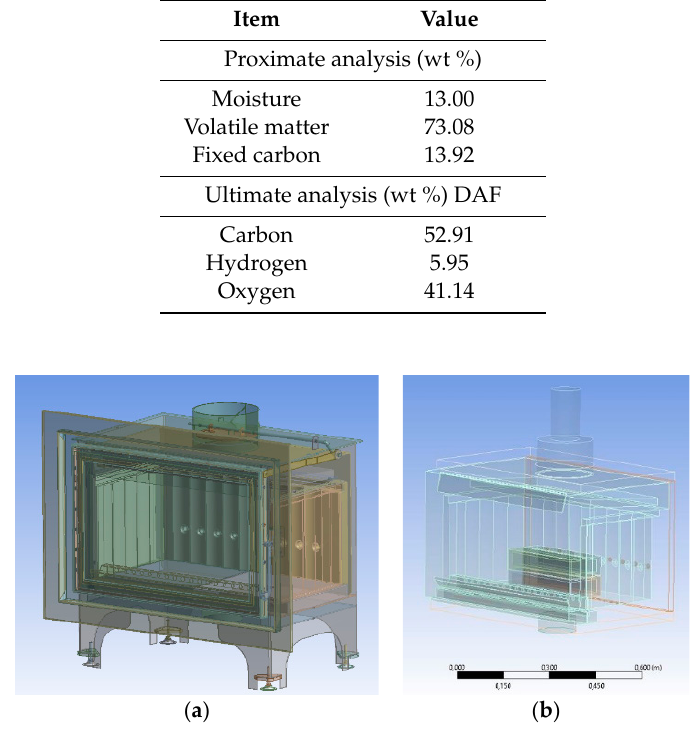
Figure 1. ( a ) View of the fireplace insert; ( b ) wood model (Case 0) [13].